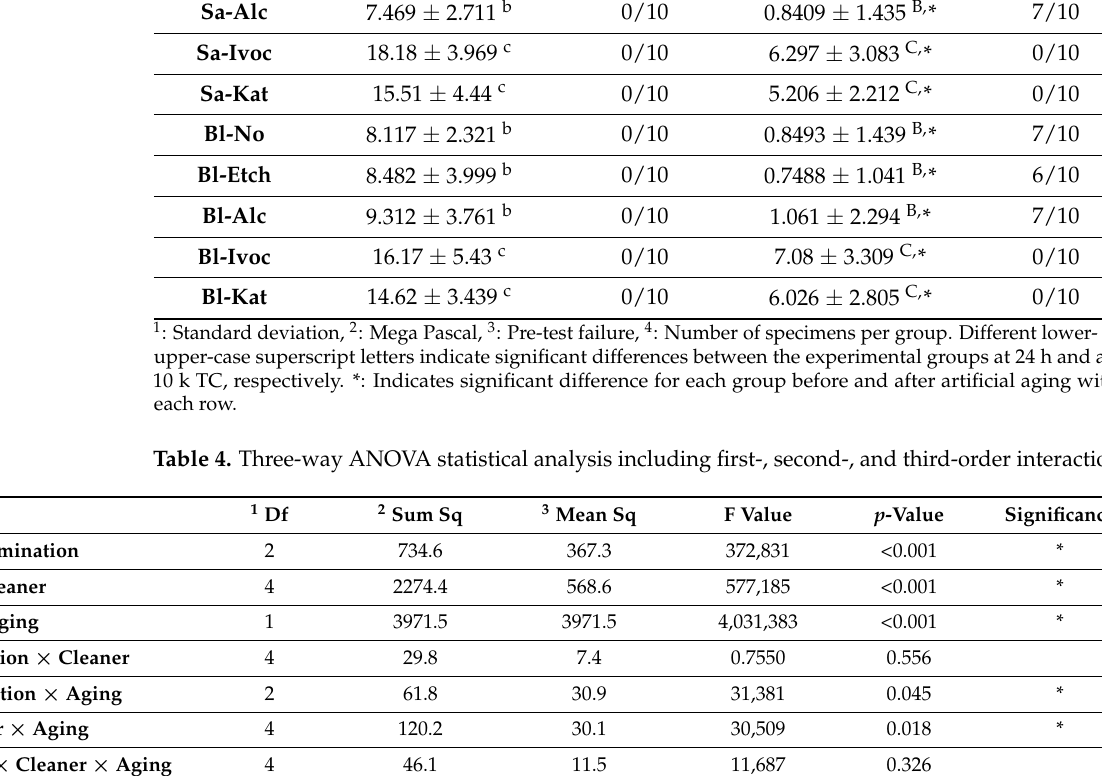
groups (Sa-No, Bl-No) at 24 h and after 10 k thermocycling. The mixed failures (Figure 5a–c) were the most predominant in the other groups at 24 h, while after thermocycling, Sa-Etch, Sa-Alc, Bl-Etch and Bl-Alc groups presented high percentages of adhesive as well as pre-test failures. No cohesive failures in ceramic (zirconia) substrate were recorded in all